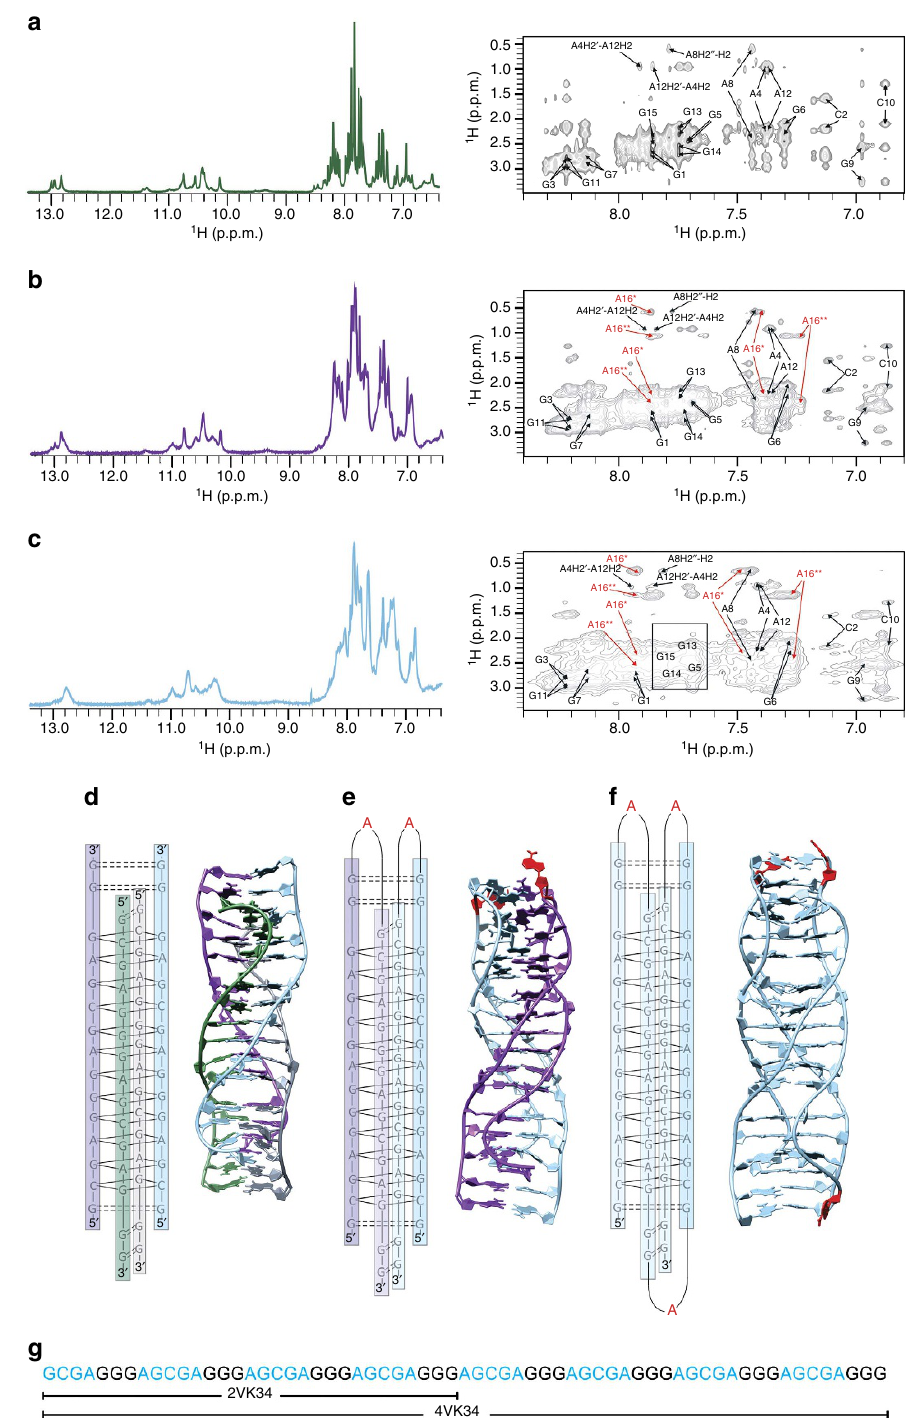
Figure 9 | Folds very similar to VK34 tetramer are adopted also by 2VK34 and 4VK34 oligonucleotides. Imino and aromatic regions of 1D 1 H NMR and H2 0 /H2 00 -aromatic region of 2D NOESYspectrum for ( a ) VK34 tetramer, ( b ) 2VK34 fold and ( c ) 4VK34 fold. The 1D 1 H and 2D NOESYspectra of 2VK34 and 4VK34 folds were recorded at 1.0mM oligonucleotide and 100mM LiCl concentrations, 0 (cid:2) C and pH 6.0. The 1D 1 H and 2D NOESY spectra of tetrameric VK34 fold were recorded at 1.2mM oligonucleotide and 100mM NaCl concentrations, 0 (cid:2) C and pH 6.0. All spectra were recorded with 200ms mixing times. ( d ) Tetrameric topology and high-resolution structure of VK34. ( e ) Dimeric topology and high-resolution structure of 2VK34. ( f )